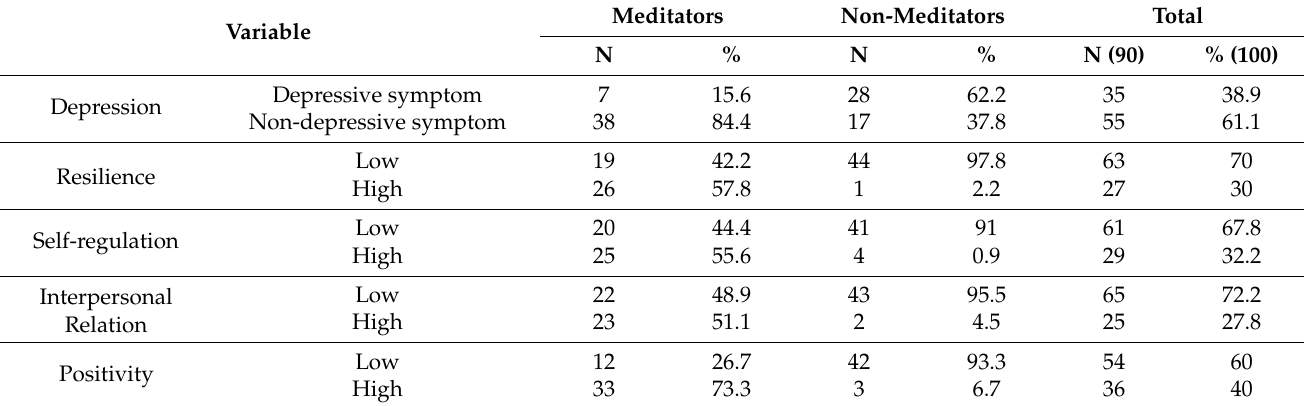
Table 4. Depressive symptoms and resilience by meditators and